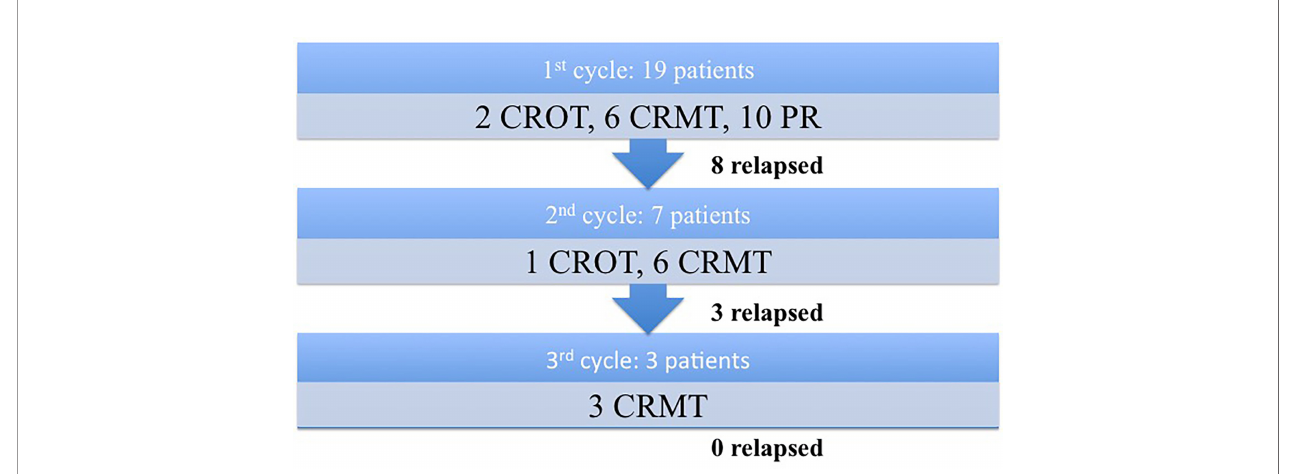
FIGURE 1 | Flowchart describing patients ’ clinical response following the administration of rituximab